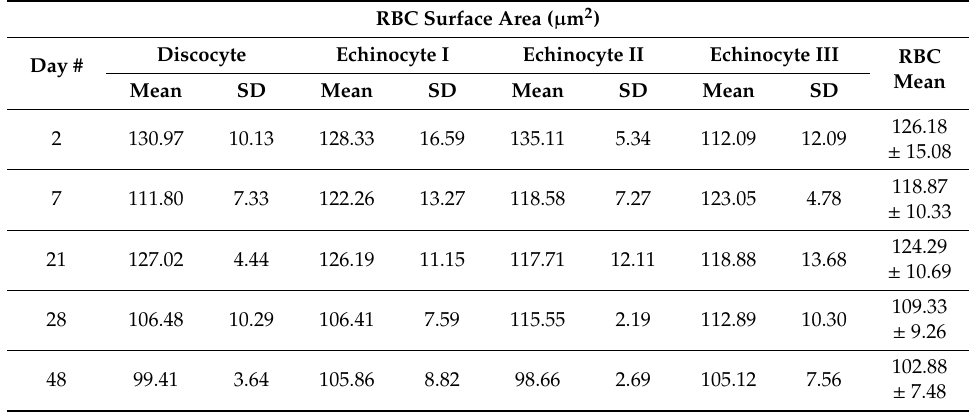
Table A2. Measurements of cell surface area of RBC morphologies of three donors during 48 days of in-vitro storage in SAGM additive solution (D. Santangelo, personal communication, 10 October 2018). Mean represents the mean values whereas SD represents the standard